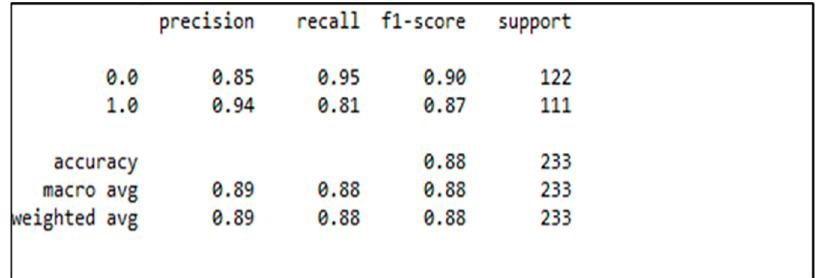
Figure 7. Classification matrix for the emotion and aura modules.